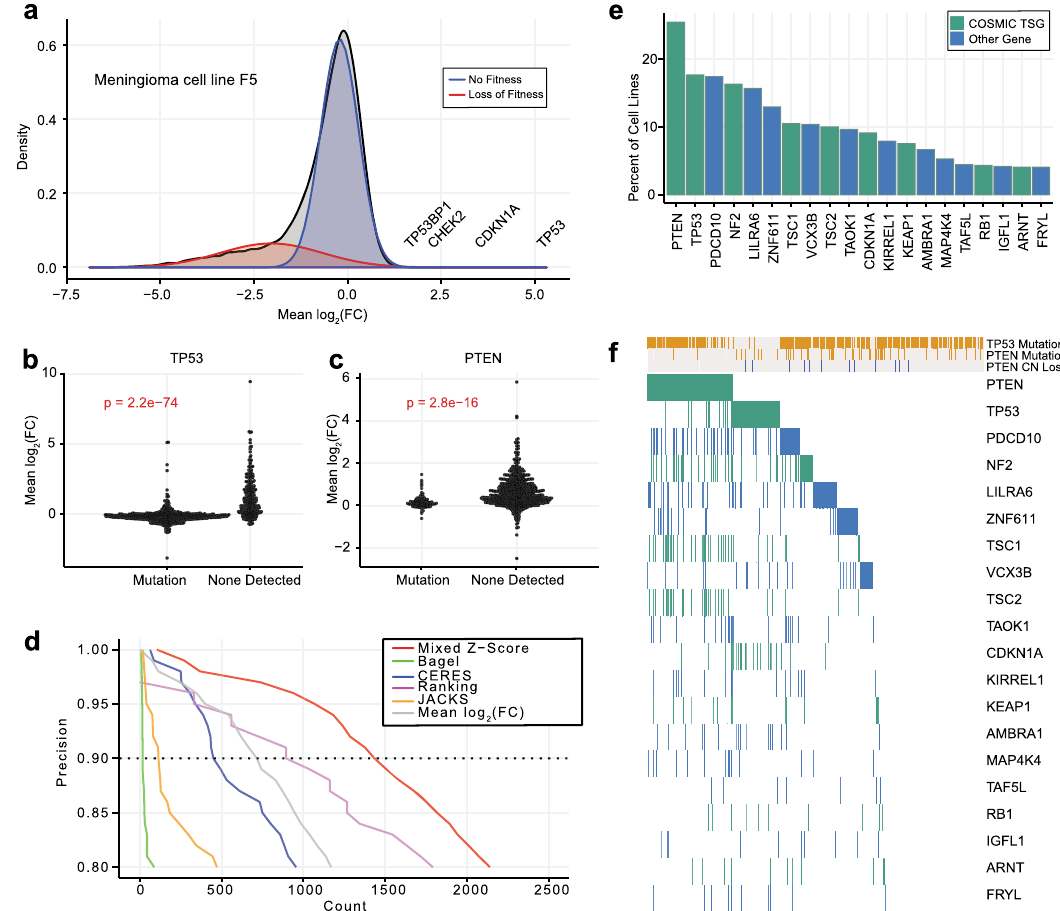
Fig. 1 Discovery of proliferation-suppressor genes. a Fold-change distribution of a typical CRISPR knockout screen has a long left tail of essential genes, and a small number of genes whose knockout increases fi tness (proliferation-suppressor genes, “ PSG ” ). A two-component Gaussian mixture model (red, blue) models this distribution. b , c Fold change of common tumor suppressors across 808 cell lines ( P values, two-sided Wilcoxon rank-sum test). d Precision vs. recall of mixed Z -score and other CRISPR analysis methods. Dashed line, 90% precision (10% FDR). e Fraction of cell lines in which known tumor suppressors (green) or other genes (blue, not de fi ned as TSG by COSMIC) are classi fi ed as PS genes at 10% FDR. f Presence of each known TSG across 808 cell lines, vs. cell genetic background. Gold, mutation present; gray, absent. Green or blue, following color scheme in ( e ), gene is classi fi ed as a proliferation